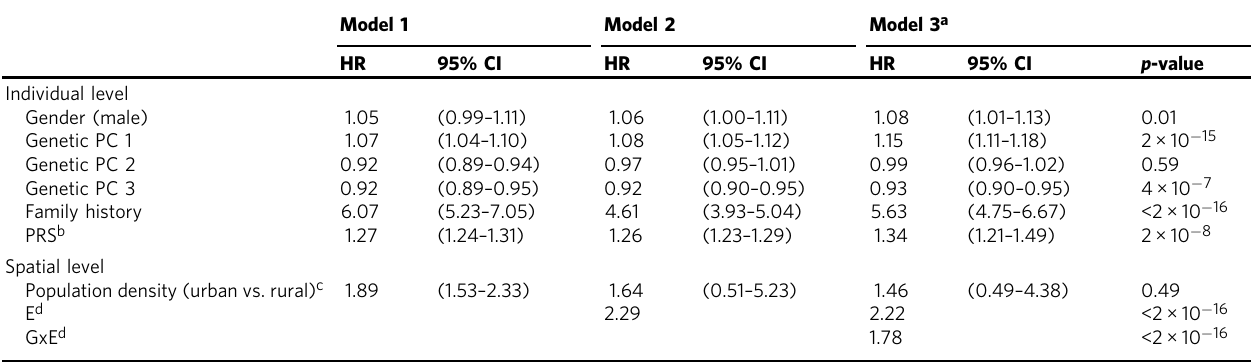
Table 1 Hazard ratio estimates from three nested Cox regression models of the iPSYCH case-cohort data